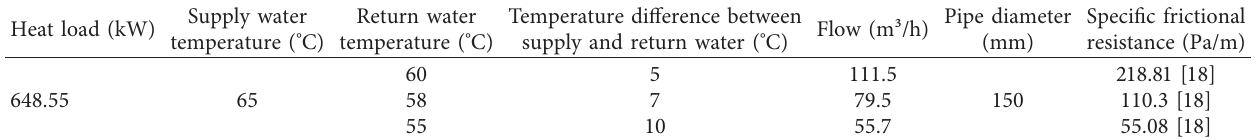
Table 3: Calculation of specific friction under different temperature